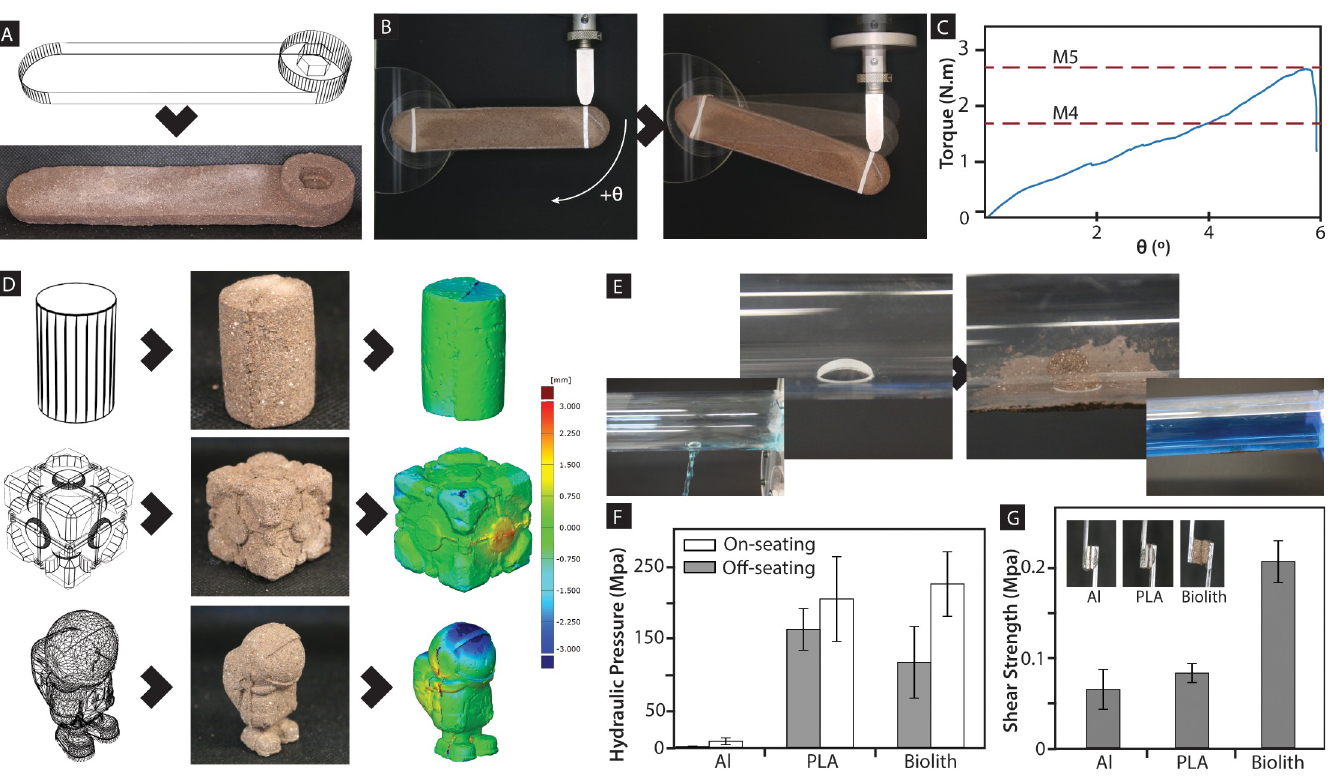
Fig 3. Demonstration of biolith utility in general manufacturing. (A) Custom-designed wrench casted with biolith that avoids failure at the handle; (B) The casted wrench was subjected to increasing vertical load after tightening to obtain maximum torque before failure; (C) The wrench sustained a maximum torque of more than 2.5 Nm before failure. In the absence of a torque wrench, the casted wrench can be designed to the desired failure load to prevent over tightening; (D) Molded samples of varying geometry intricacies to demonstrate biolith’s ability to replicate object geometries; (E) The ability of biolith to form a mechanical sealing is critical to stop leakage from a drilled hole in a chemically inert acrylic tube; (F) Differences in substrate material properties, such as material stiffness, could affect the maximum pressure sustained before the sealing is compromised via rupture or substantial leakage; (G) Initial hypothesis for enhanced sealing due to surface interaction was not validated as there was no significant difference in the shear strength of biolith applied onto aluminum or PLA surfaces.